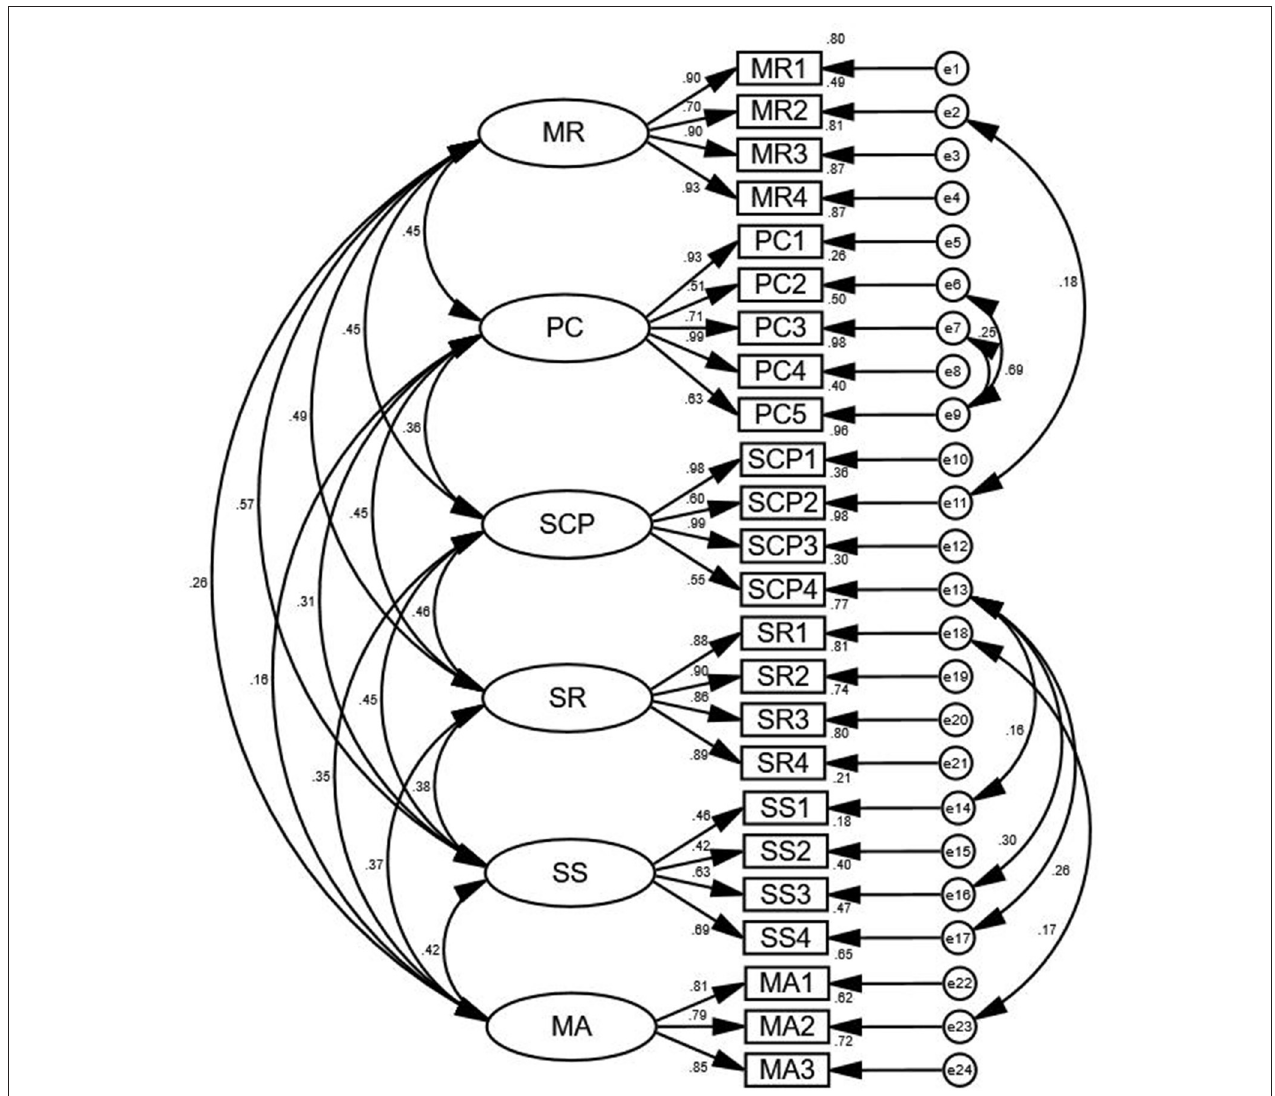
FIGURE 4 | Standardized three-factor structural model of the BMSCS ( n = 255). MR, Mindful Relaxation; PC, Physical Care; SCP, Self-Compassion and Purpose; SR, Supportive Relationships; SS, Supportive Structure; MA, Mindful